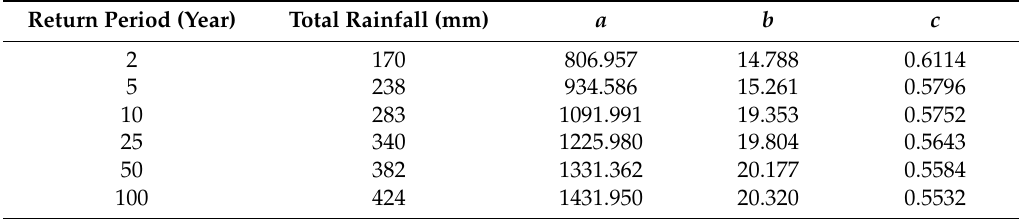
Table 1. The total rainfalls of 24-h duration and the regression coefficients of Horner’s equation of various return